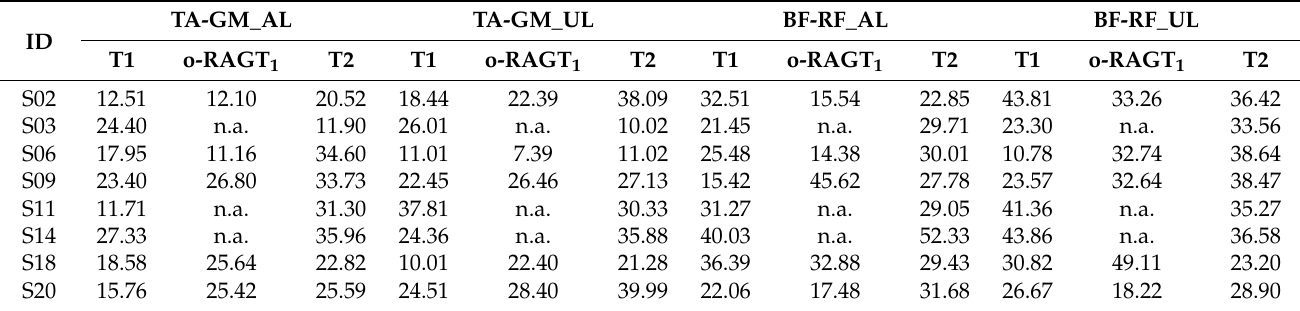
Abbreviations: Tibialis Anterior-Gastrocnemius Medialis Affected lower Limb (TA-GM_AL); Tibialis Anterior-Gastrocnemius Medialis Unaffected lower Limb (TA-GM_UL); Biceps Femoris-Rectus Femoris Affected lower Limb (BF-RF_AL); Biceps Femoris-Rectus Femoris Unaffected lower Limb (BF-RF_UL); not available (n.a.). Brain Sci. 2021 , 11 , x FOR PEER REVIEW 9 of 13 Figure 2 shows the RMS coefficients at T1, T2, and o-RAGT 1 as mean and standard deviations values calculated on the whole sample. A mean increase of muscle activity (RMS) was registered at T2 in TA (affected and unaffected sides), GM (affected side), BF (affected and unaffected sides), and RF (unaffected sides). However, the standard deviations of RMS were high. The WPE (at o-RAGT 1 ) increased the RMS coefficient of TA, GM, BF, and RF in the affected side only.